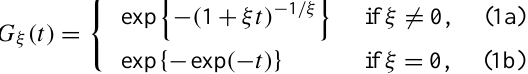
the return levels predicted by RS ref . Pearsons correlation is 0.73.